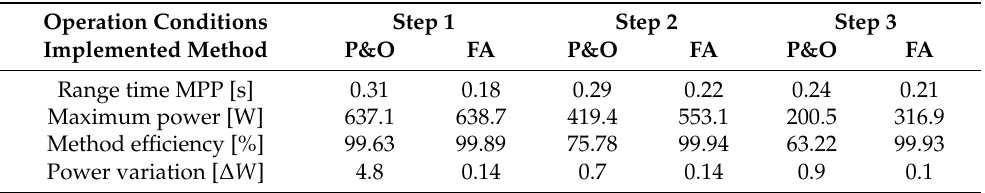
Table 2. Comparison data obtained by the algorithm simulations P&O and